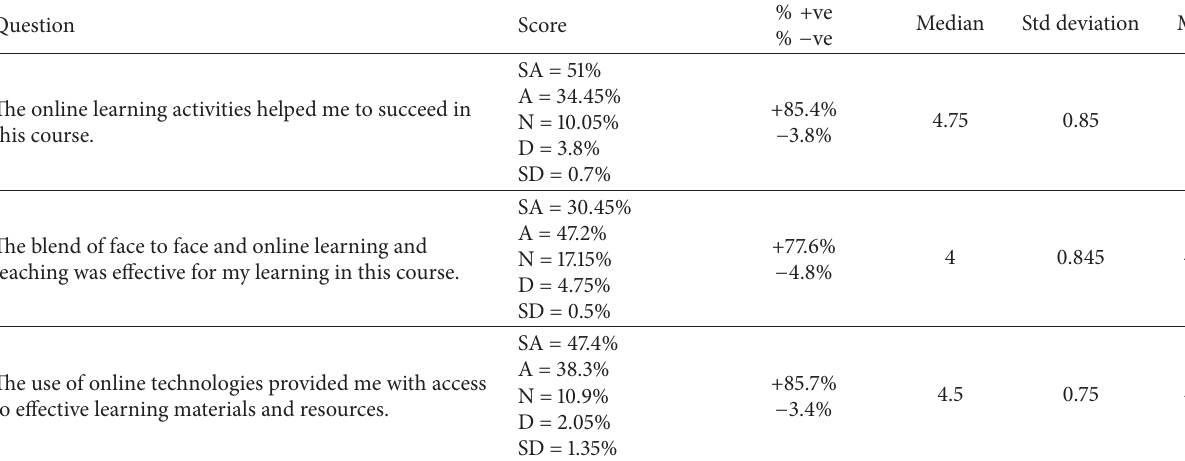
Table 4: Showing a summary of the results of the additional SEC questions related to the online resources developed in the head and neck anatomy course. SA: strongly agree, A: agree, N: neutral, D: disagree, and SD: strongly disagree. Question Score